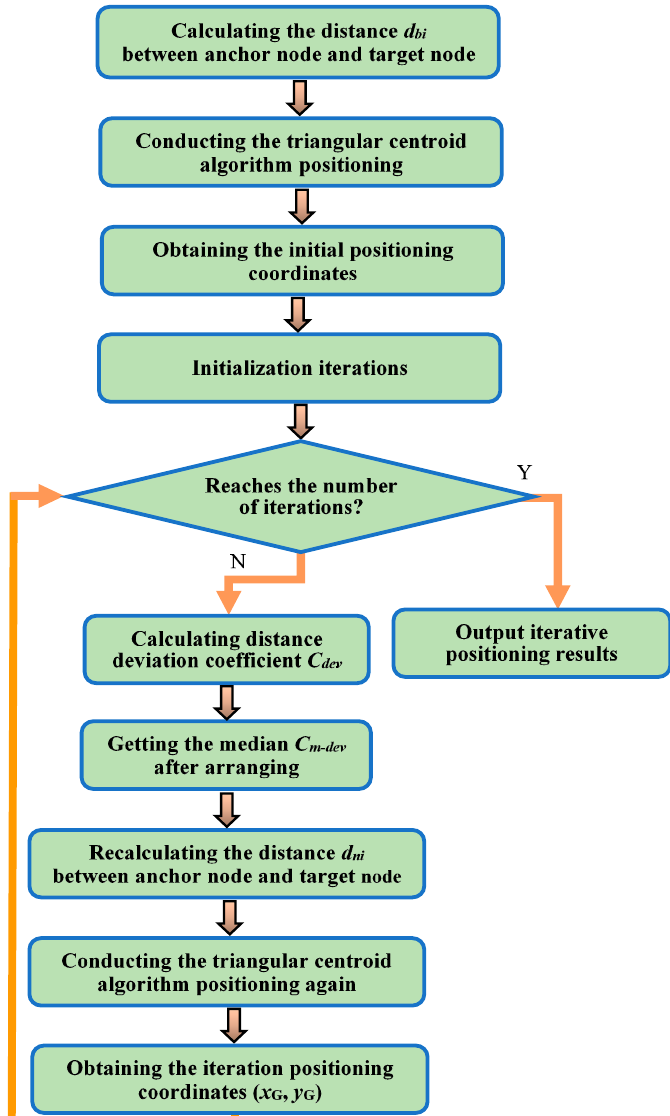
Figure 3. A flow chart of the iterative positioning algorithm.The C dev is the distance deviation coefficient in Figure 1. The C m-dev is the median of the distance deviation coefficients C dev .